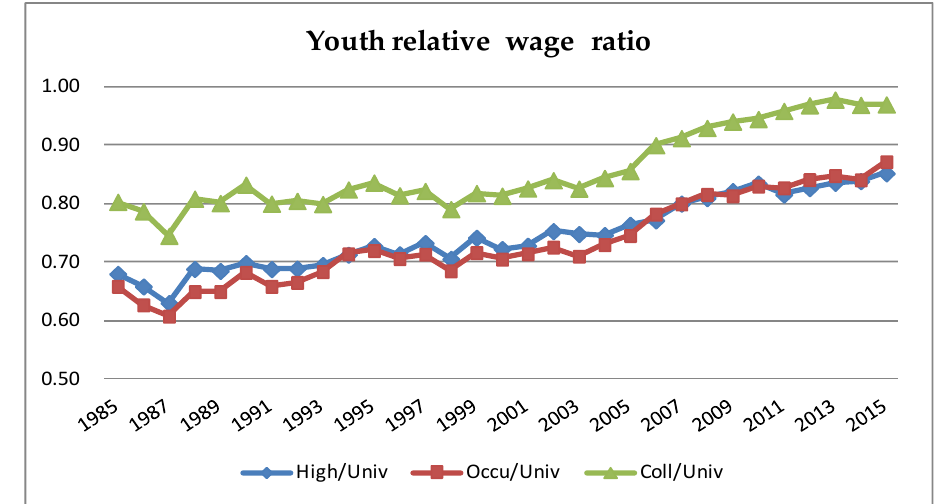
Figure 5. Junior relative wage ratio. Source: same as Figure 1.